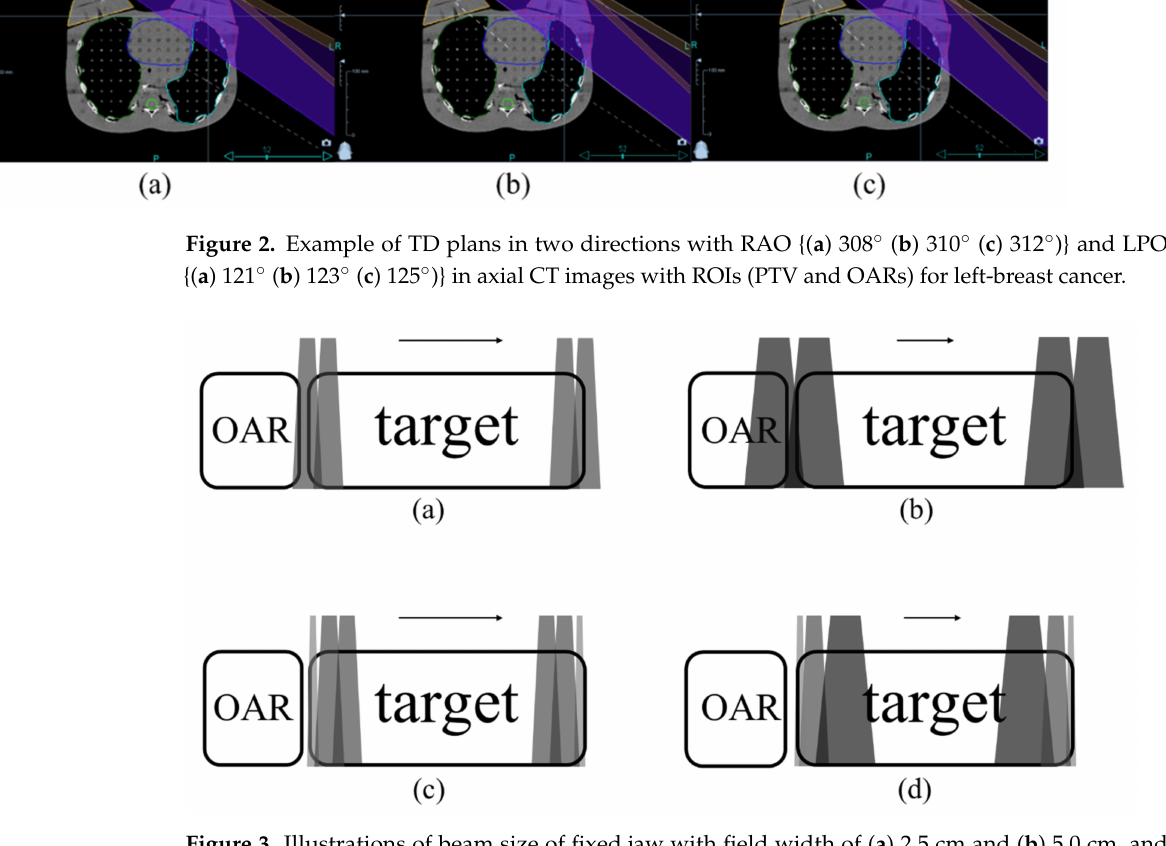
Figure 3. Illustrations of beam size of fixed jaw with field width of ( a ) 2.5 cm and ( b ) 5.0 cm, and dynamic jaw width with field width of ( c ) 2.5 cm and ( d ) 5.0 cm. Fixed mode has higher dose penumbras to OARs adjacent to the